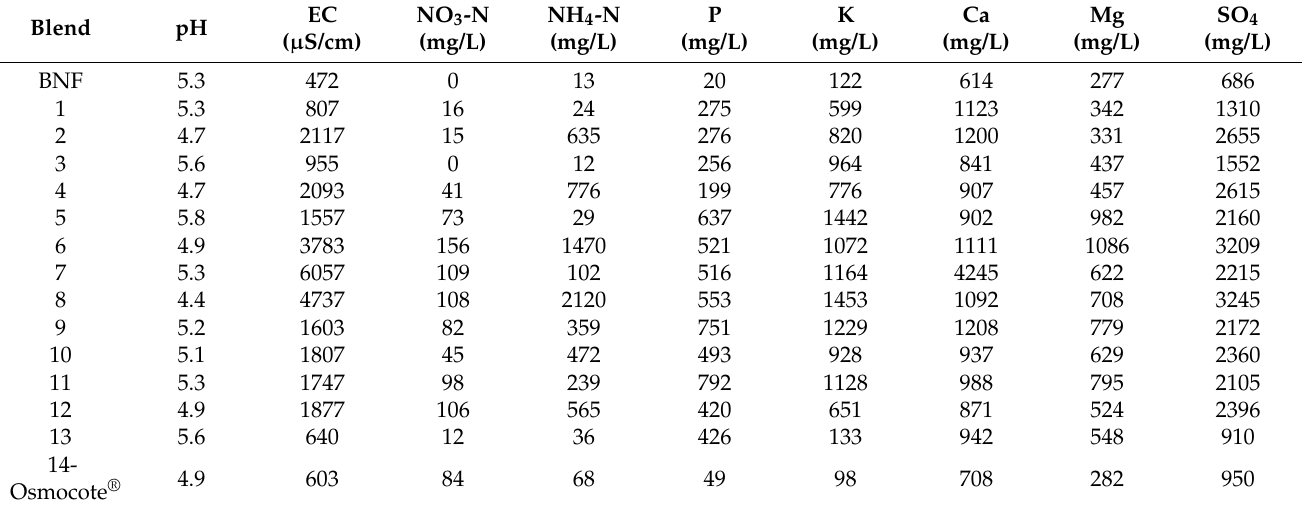
Table 3. pH, EC, and plant available nutrients measured in the growing medium after the addition of the 14 fertilizer blends, and in the BNF = blank/control, containing no additional fertiliser.